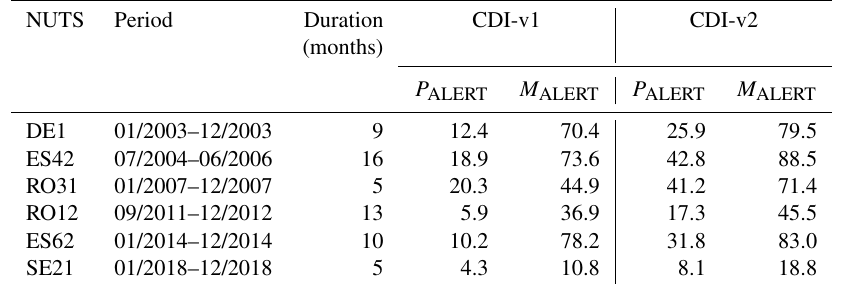
Table 3. ALERT stage statistics over the NUTS regions with observed yield impacts during drought events (see Table 1). P ALERT is the average percentage of the ALERT stage during the drought duration, and M ALERT is the maximum percentage in the same period. The drought duration is defined as the period when the percentage of the NUTS with WATCH + WARNING + ALERT is > 20% for either CDI-v1 or CDI-v2. Please note that the date format in this table is month year (mm/yyyy).